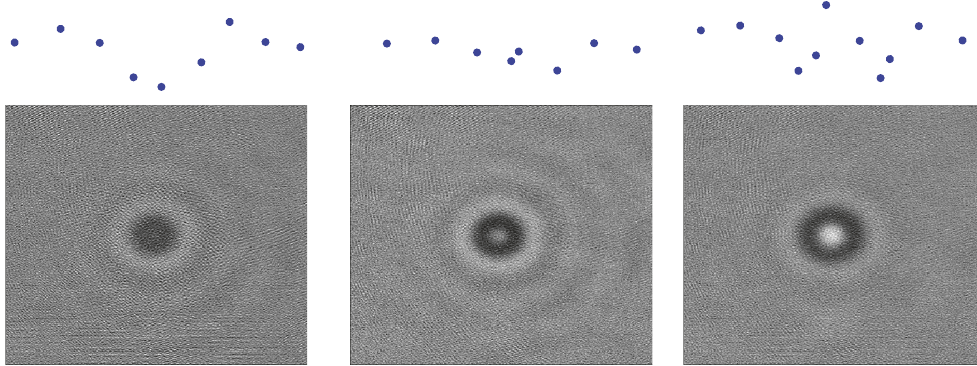
Figure 4: Experimental results. (a) One-dimensional intensity distributions. Blue dotted lines represent experimental results, and red solid lines represent calculation results. (b) Light intensity distributions acquired by